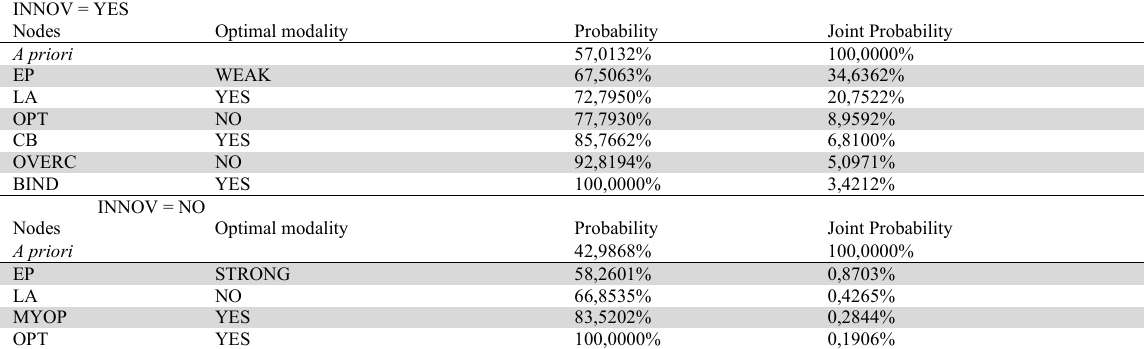
Target dynamic profile